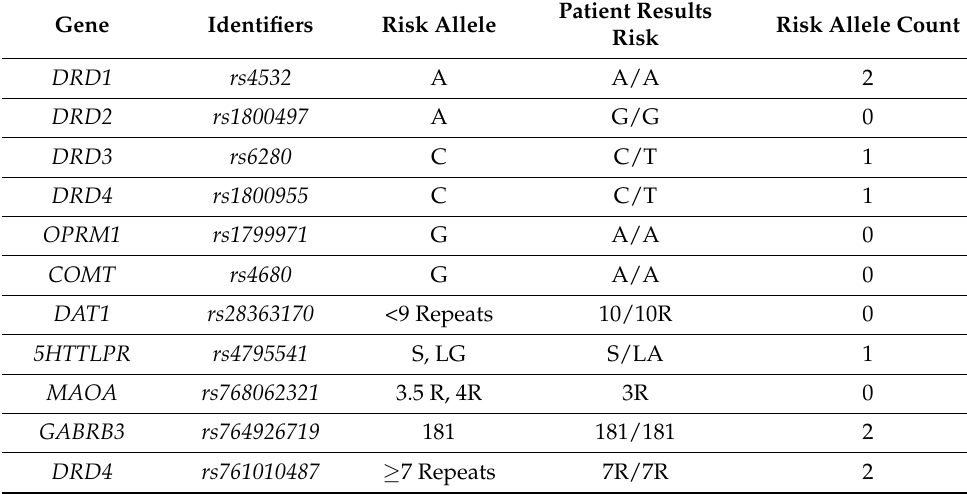
Table 10. Father’s GARS test results